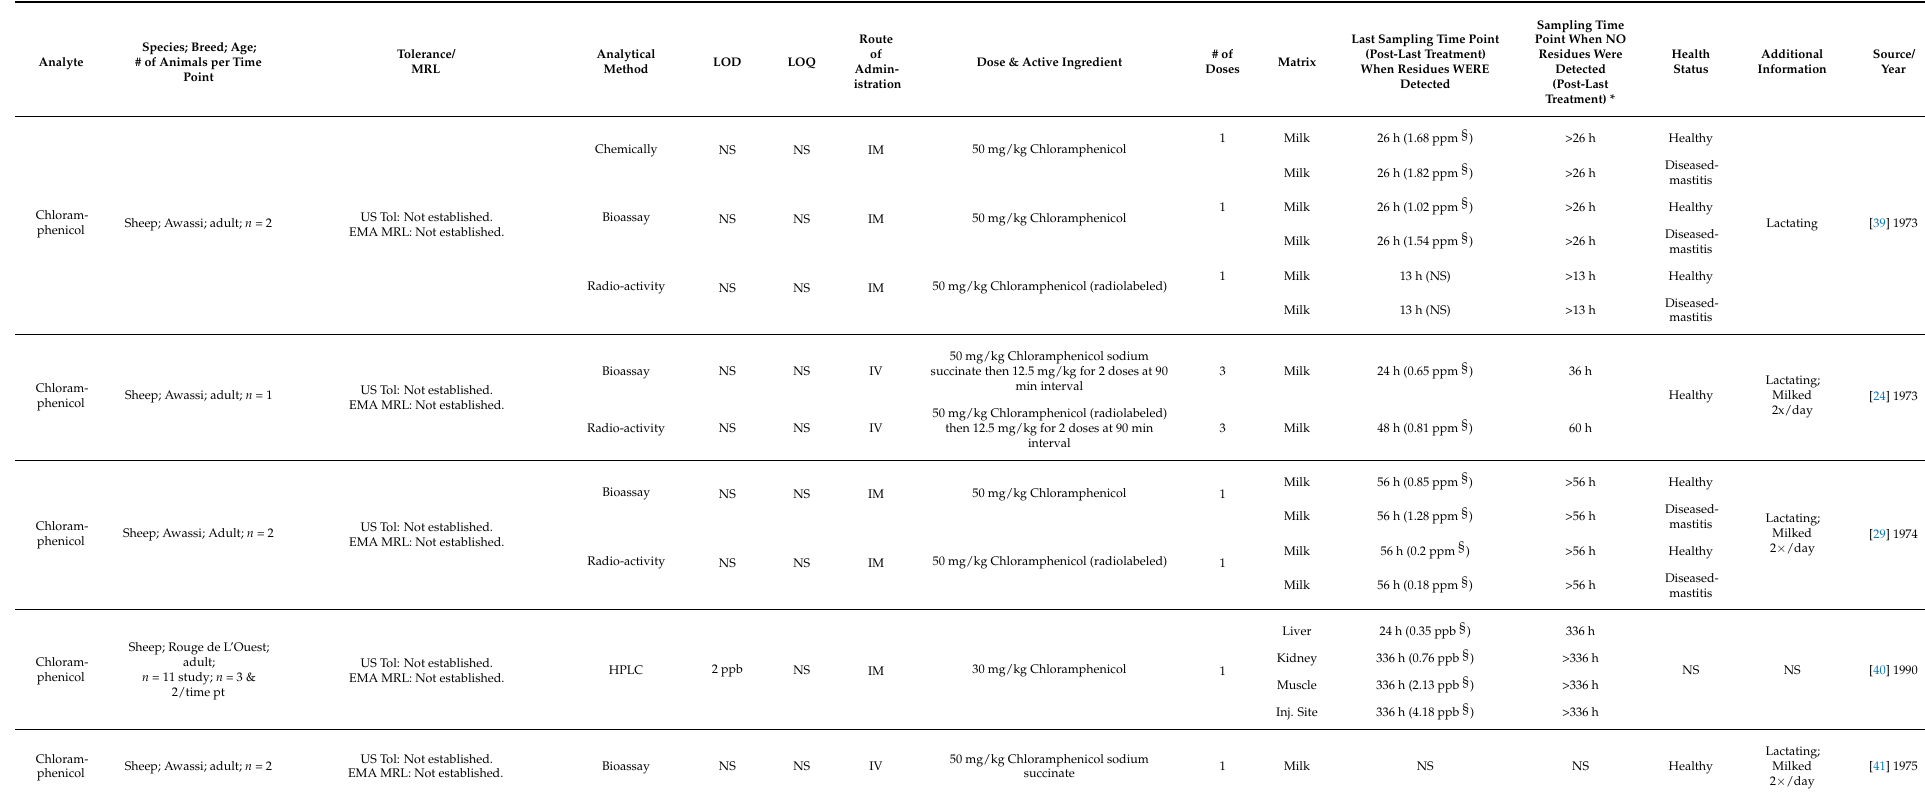
Analytical Method LOD LOQ